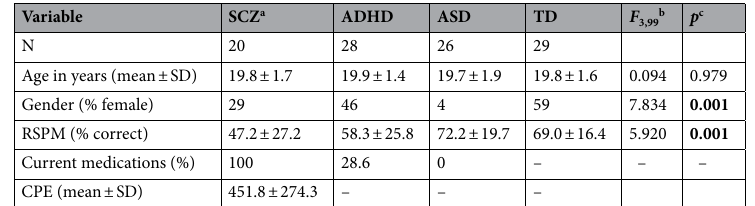
Table 1. Group’s characteristics. RSPM Raven standard progressive matrices, CPE Chlorpromazine equivalent, SD standard deviation. Column for each group reports Mean ± SD. a Of the SCZ patients, one had an additional ADHD diagnosis (without taking psychostimulants), another one of autism with below-average IQ. Data of these two patients were included in the final analyses, since excluding them did not alter the results. Data from one patient from the SCZ group were excluded from analysis as he did not complete all tasks, which prevented the comparison of the performance between tasks. Patients from the ADHD group taking stimulant medication were medication-free for at least 24 h prior to testing, while patients from the SCZ group remained on their medications prior to and during testing. b Analysis of variance (ANOVA) was used. c Bold typeface = p < 0.05. p values for all variables indicate significance for differences between each clinical group and